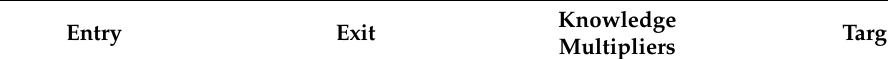
Table 4. Evaluation